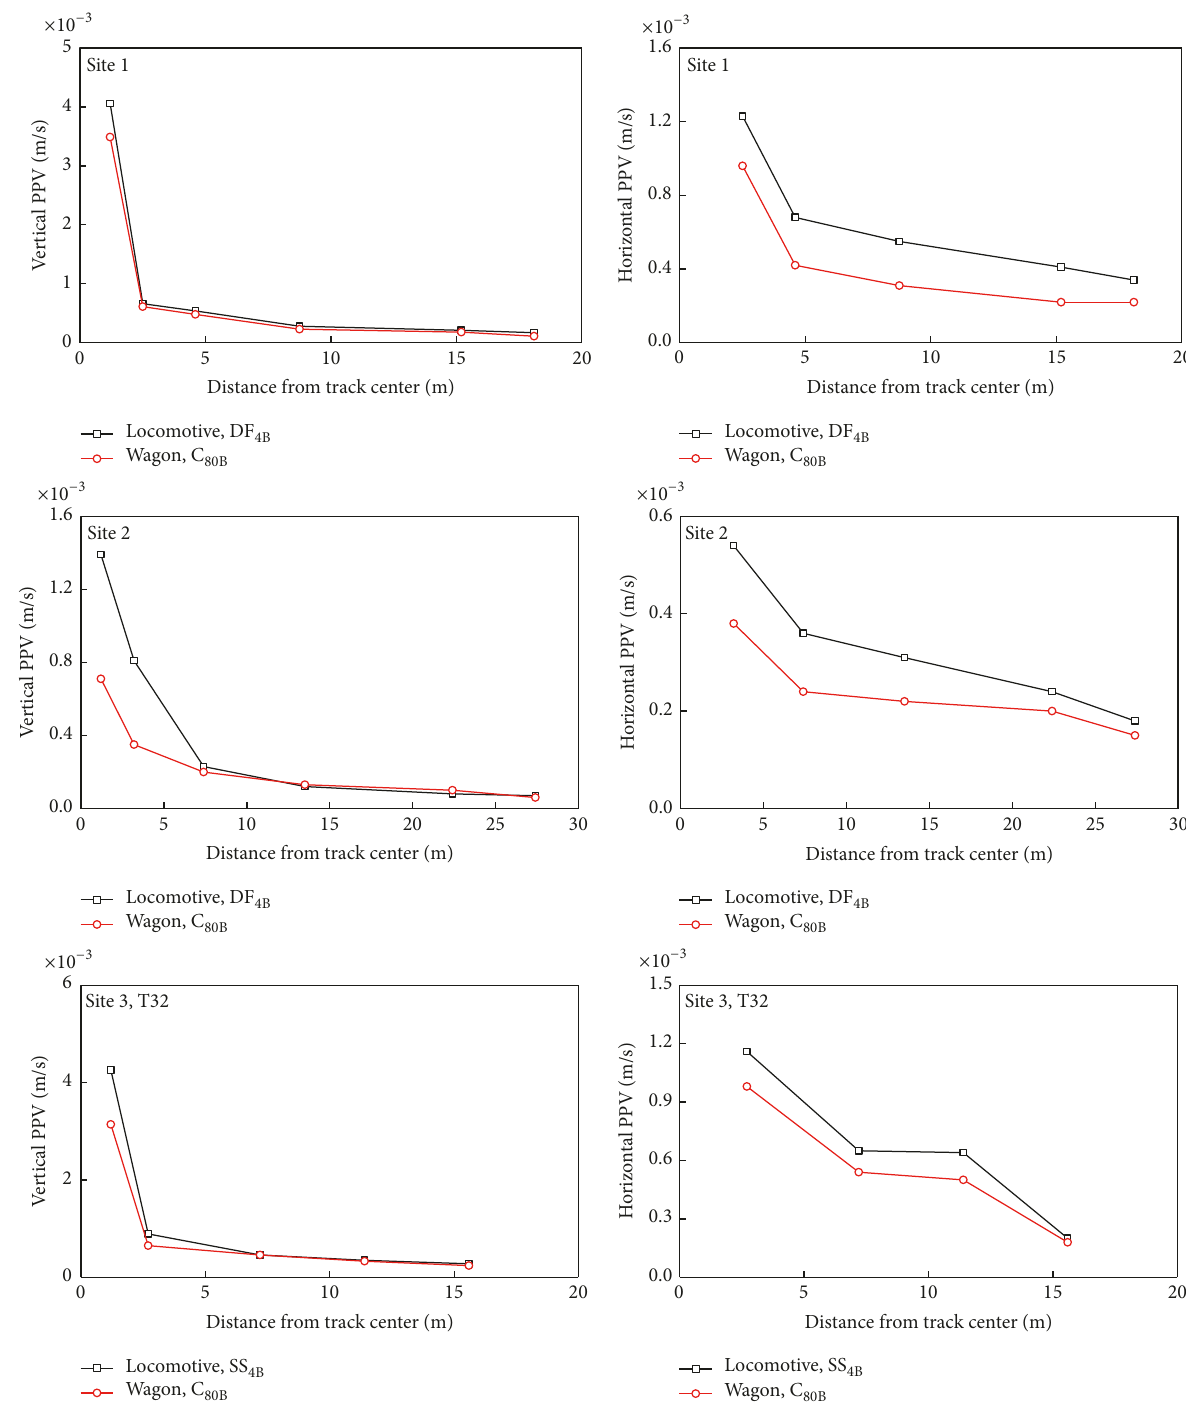
Figure 11: Comparison of PPV induced by locomotive and